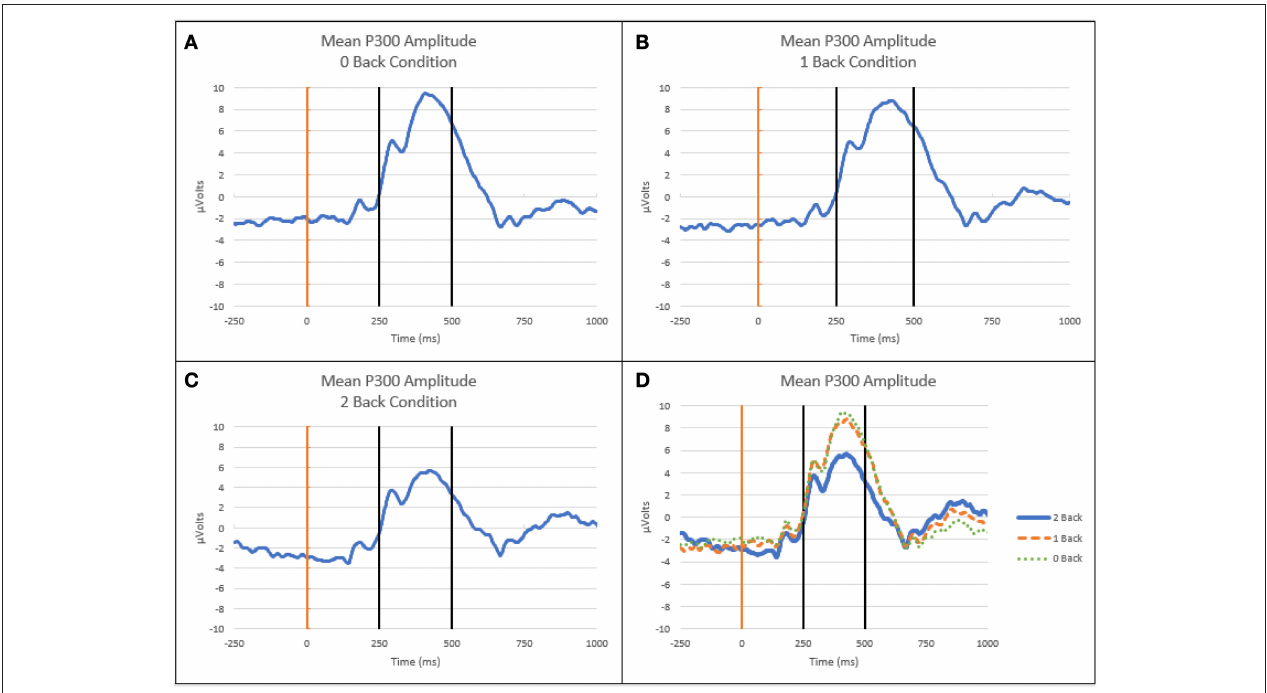
FIGURE 4 | ERP waveforms at Pz electrode. (A) Mean ERP curve for 0-back level. (B) Mean ERP curve for 1-back level. (C) Mean ERP curve for 2-back level. (D) Mean ERP curves at all workload levels. Light vertical line is onset of Flanker stimulus, dark vertical lines indicate time window for mean P300 amplitude calculation (250–500 ms post-stimulus onset).